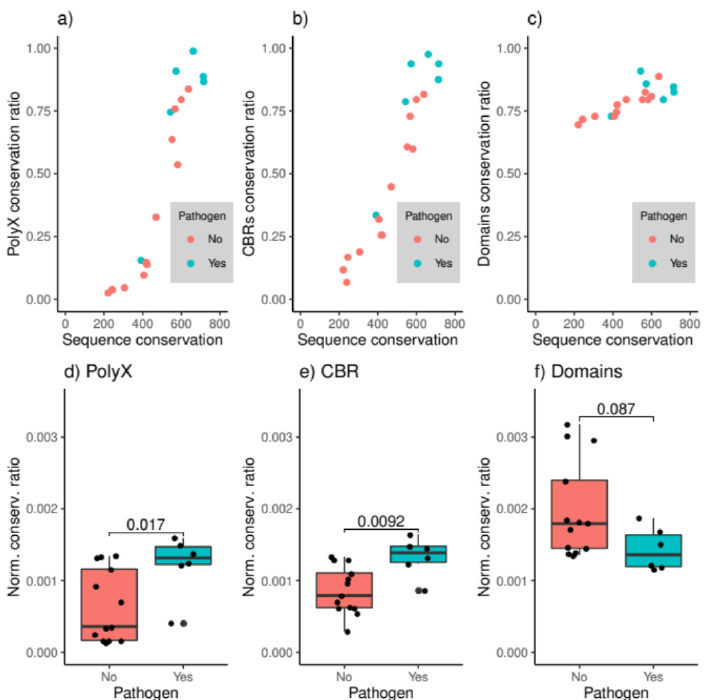
Figure 3. ( a – c ) PolyX, CBRs, and domain conservation ratio compared to sequence conservation (mean bit score) for pathogenic and non-pathogenic strain pairs; ( d – f ) polyX, CBRs, and domain conservation ratio normalized by the sequence conservation for pathogenic and non-pathogenic strain pairs. Non-parametric Mann–Whitney U statistical tests were performed to compare the